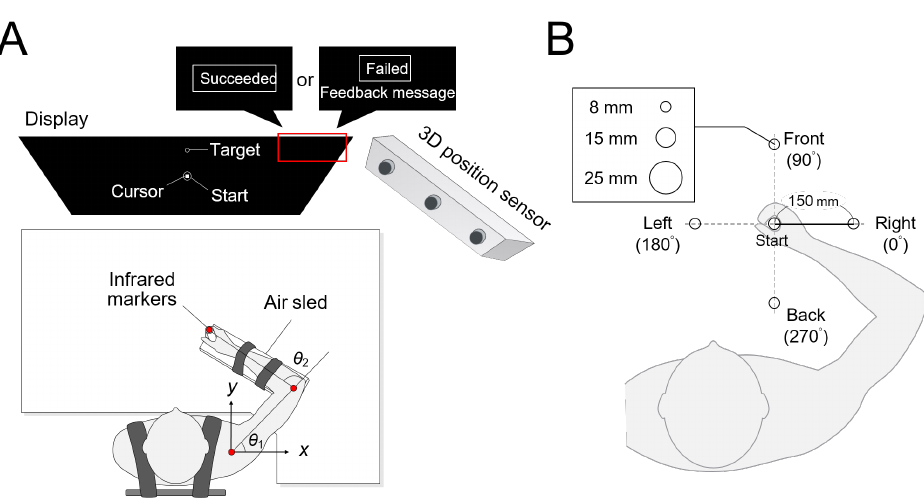
Figure 3. Top view of experimental setup. ( A ) Experimental environment, showing definitions of joint angles θ 1 and θ 2 and x – and y –coordinates; similar to our previous study [23]. ( B ) Conditions of three different target sizes and the placements of four target positions with respect to the central